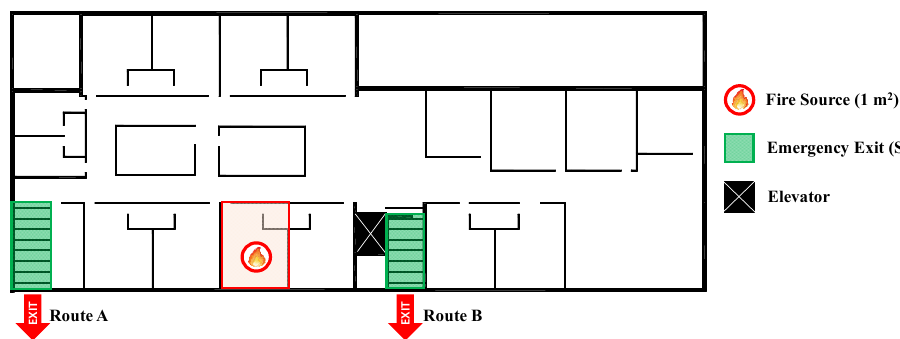
Figure 3. Location of fire combustion and egress routes.